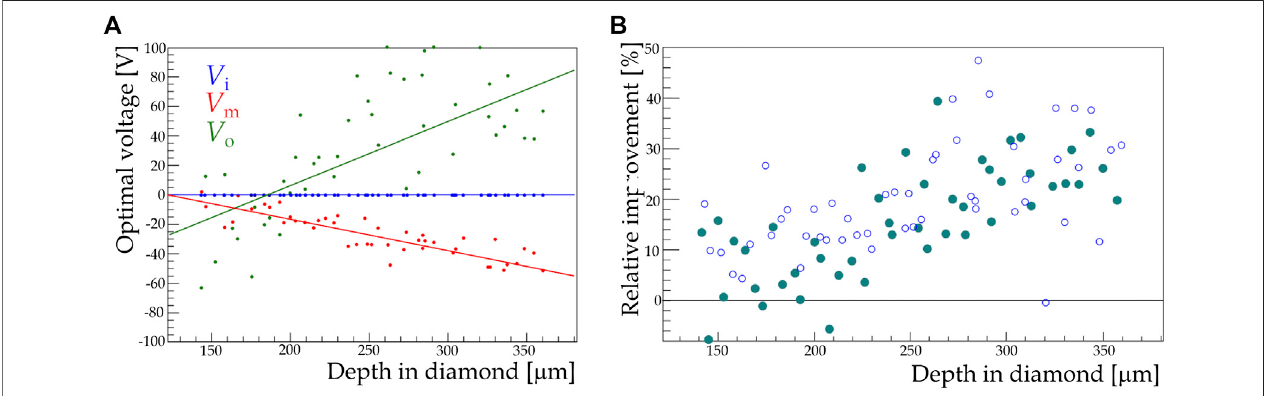
FIGURE5|(A) Theoptimalvaluesforthevoltagesappliedtothepiezoelectricmotorscontrollingthedeformablemirrorasdeterminedwithaniterativeoptimisation procedure.Alinearmodeldescribingthedependenceoftheoptimalvoltageonthedepthindiamondissuperimposed. (B) therelativeimprovementinthefocusquality Q obtained from direct optimisation (empty markers) or obtaining the voltages as a function of the depth from the linear models shown in (A) (full markers).